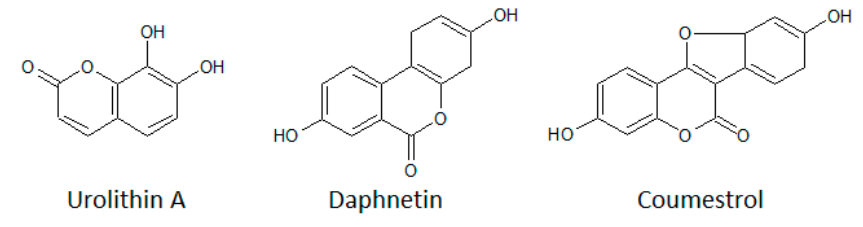
Figure 6. Structures of coumarin derivatives.